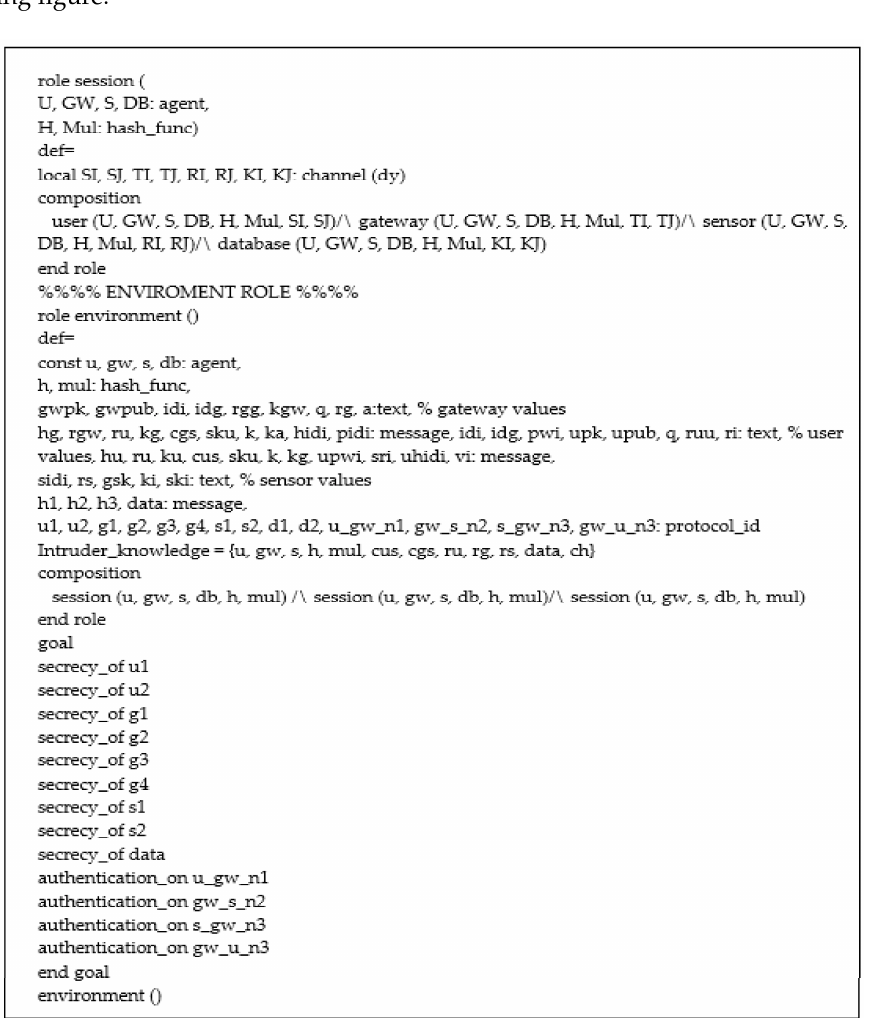
Figure A4. Role of the database.